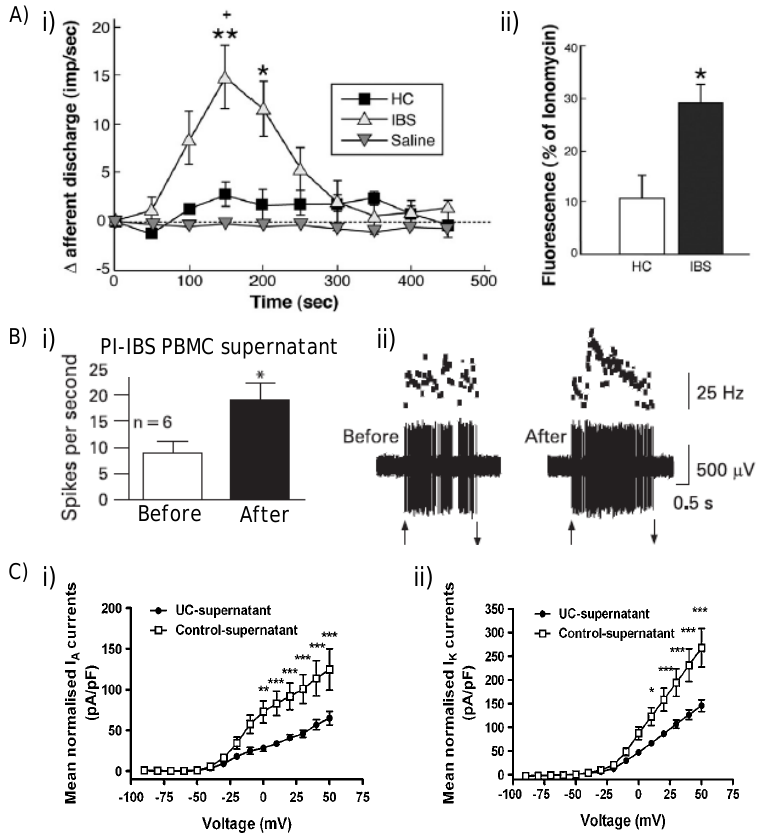
Figure 6. Supernatants from visceral pain patients alter visceral afferent function. ( A ) ( A i ) Mucosal supernatants obtained from colonic mucosal biopsies of IBS patients increase the nerve discharge of rat jejunal afferents compared with healthy controls (HC) or saline alone; ( A ii ) When tested on isolated DRG neurons the IBS supernatant-induced increases in intracellular Ca 2+ were significantly higher than those obtained with supernatants from healthy control (HC) patients. Modified from Barbara et al. [26] with permission; ( B ) ( B i ) Peripheral blood mononuclear cell (PBMC) supernatants from post-infectious diarrhoea- predominant Irritable Bowel Syndrome (PI-IBS) patients cause a marked increase in the mechanosensory response of mouse pelvic colonic serosal afferents; ( B ii ) Original record on the mechanosensory response of a pelvic serosal afferent before and after PI-IBS supernatants. Modified from Hughes et al. [168] with permission; ( C ) Supernatants obtained from colonic biopsies from Ulcerative Colitis (UC) patients cause significant decreases in colonic DRG neuron ( C i ) K I currents and ( C ii ) I currents compared with control V A K supernatant. Modified from Ibeakanma and Vanner [169] with